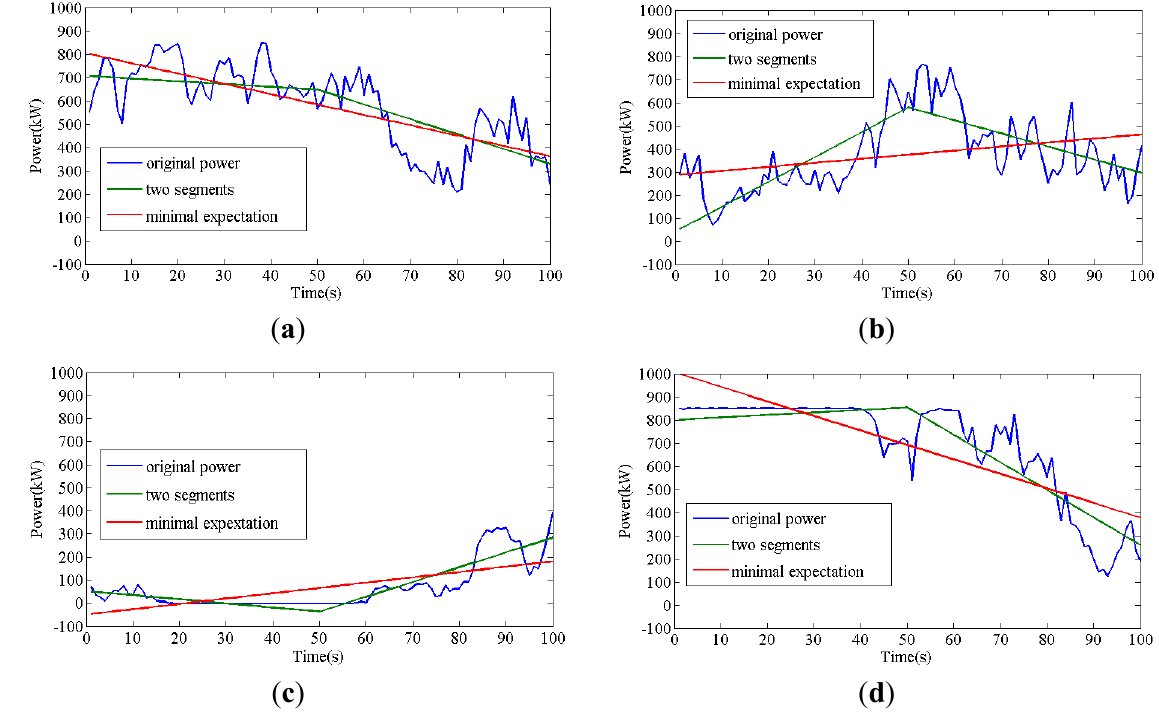
Figure 3. Regulation effect comparison of the two methods.